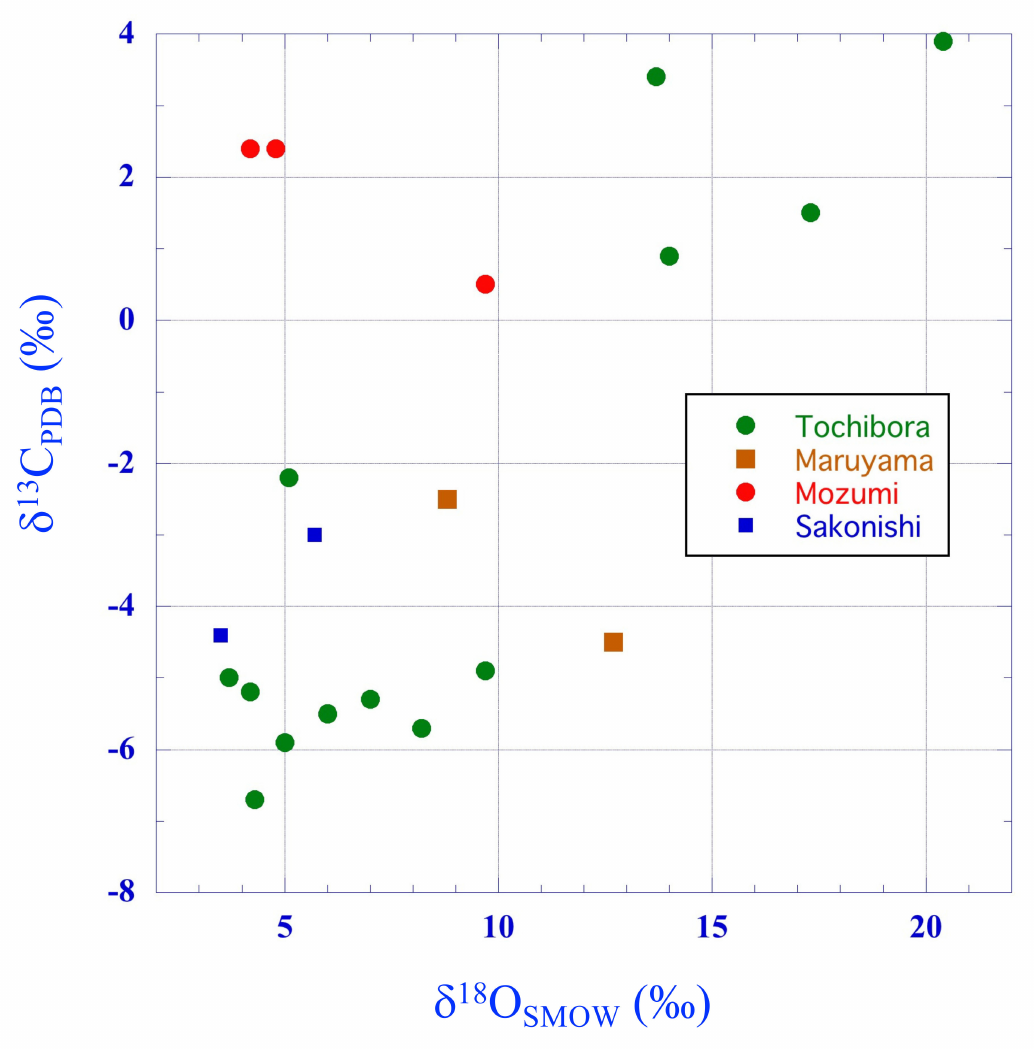
Figure 3. The δ 13 C and δ 18 O values of calcite from the Tochibora, Maruyama, and Mozumi deposits and from the Sakonishi area in the Kamioka mining district (Table